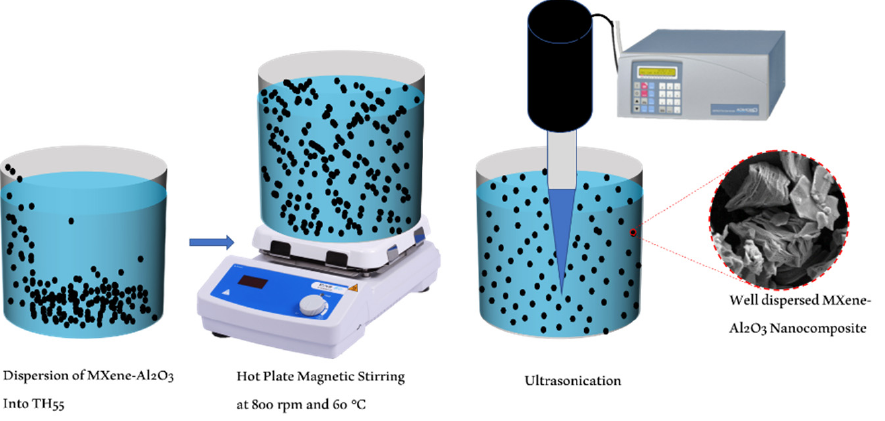
Figure 1. Two-step preparation of TH55/MXene + Al 2 O 3